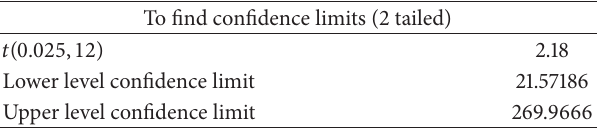
Table 8: Confidence limits